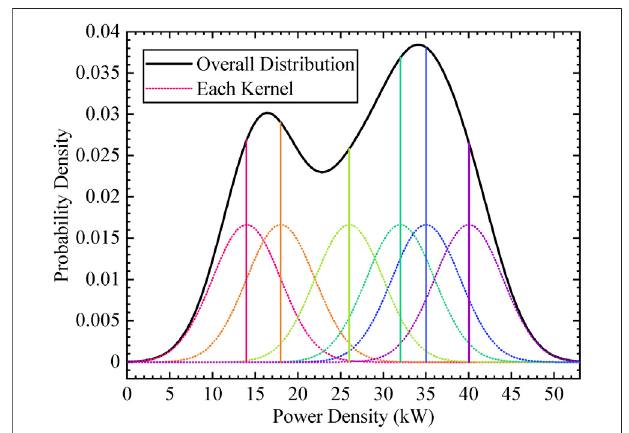
FIGURE 4 | The mechanism of kernel density